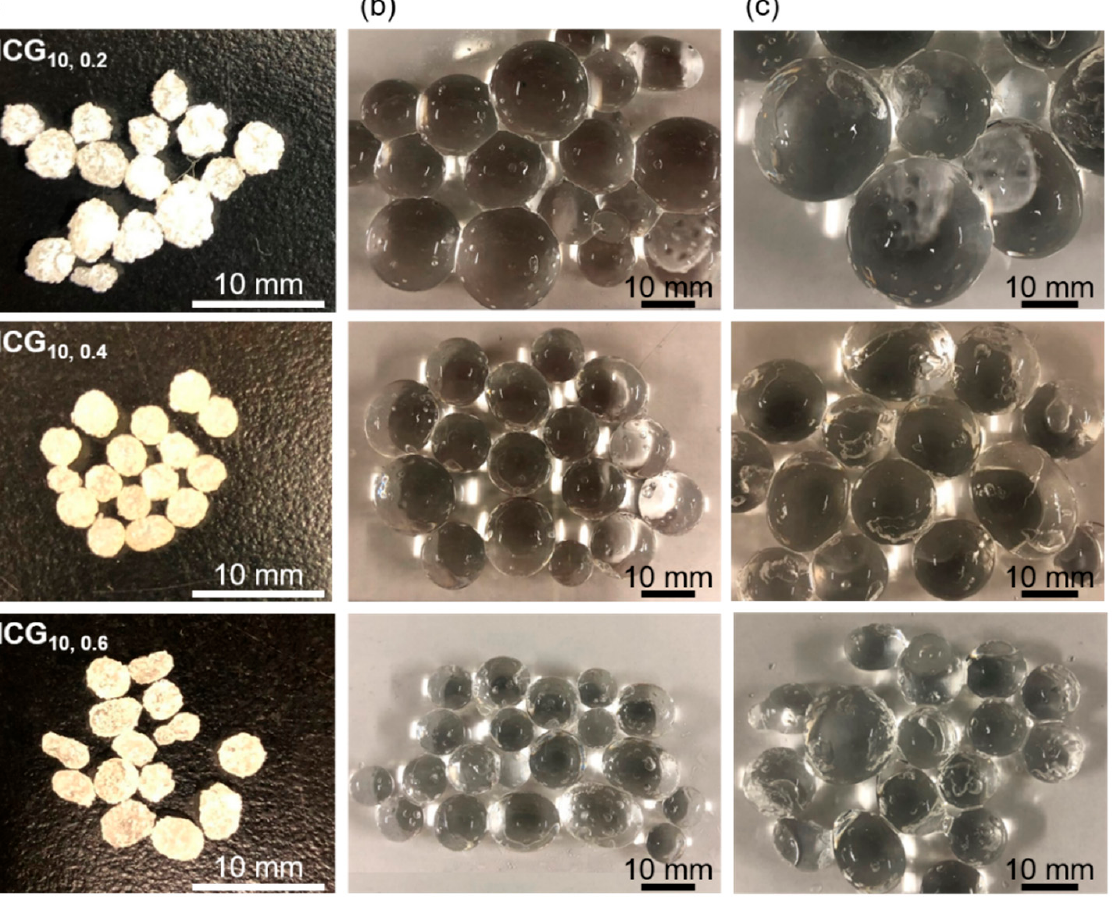
Figure 7. Photographs showing the appearance of the CMCGs: ( a ) dried, swollen with ( b ) PBS, and ( c ) pure water, after 48 h.